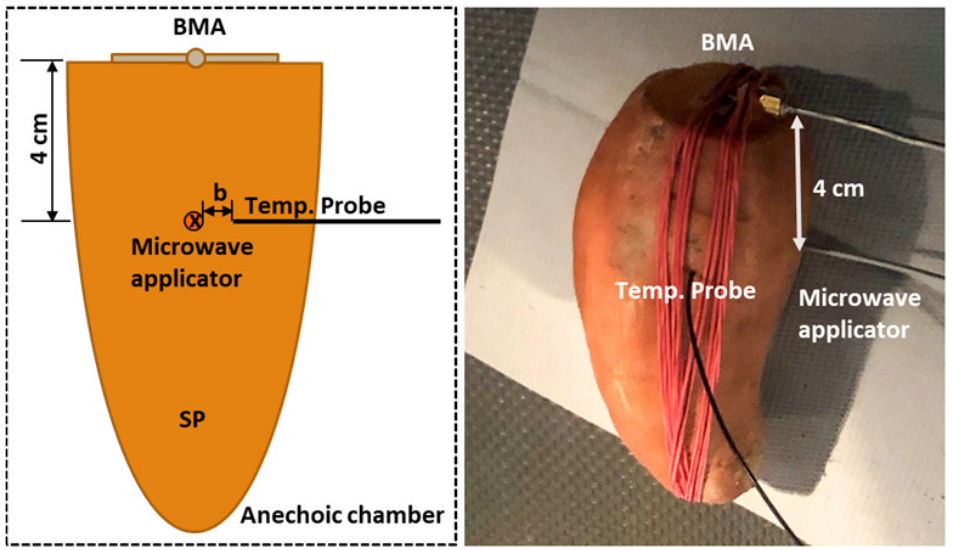
Figure 6. MWA experimental setup for